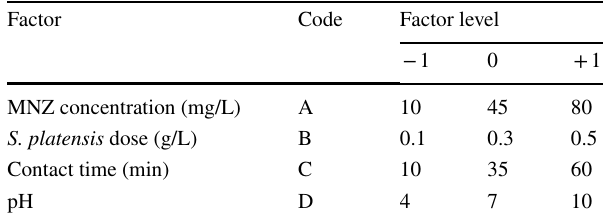
Table 1 Range and levels of independent factors used for the MNZ